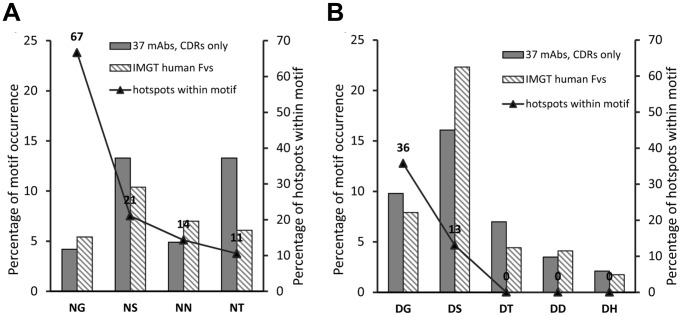
Occurrence of Asn and Asp amino acid motifs in the CDRs of a therapeutic mAb collection and a set of naturally occurring antibodies (IMGT).Black triangles show percentages of hotspots within Asn and Asp motifs of the experimental collection of 37 mAbs. Bars represent percentages of depicted sequence motifs among all Asn or Asp residues in only CDR regions. Percentages shown as filled bars represent the non-redundant collection of the 37 analytically assessed therapeutic mAbs, bars striped in light grey belong to a collection of 9990 V-D-J- and 6296 V-J regions of naturally occurring antibodies from the IMGT database. (A) Asn sequence motifs, (B) Asp sequence motifs.